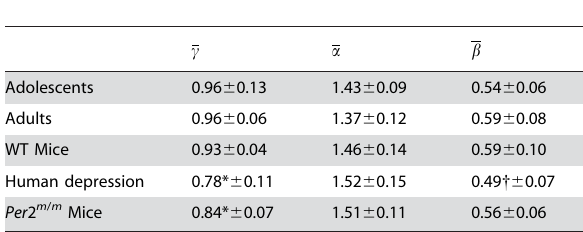
Table 1. Fitting parameters of rescaled cumulative